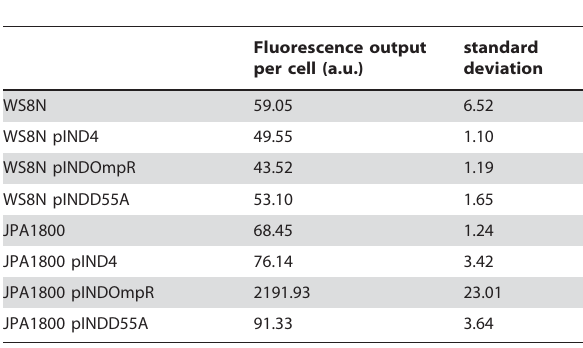
Table 2. Fluorescence output data.